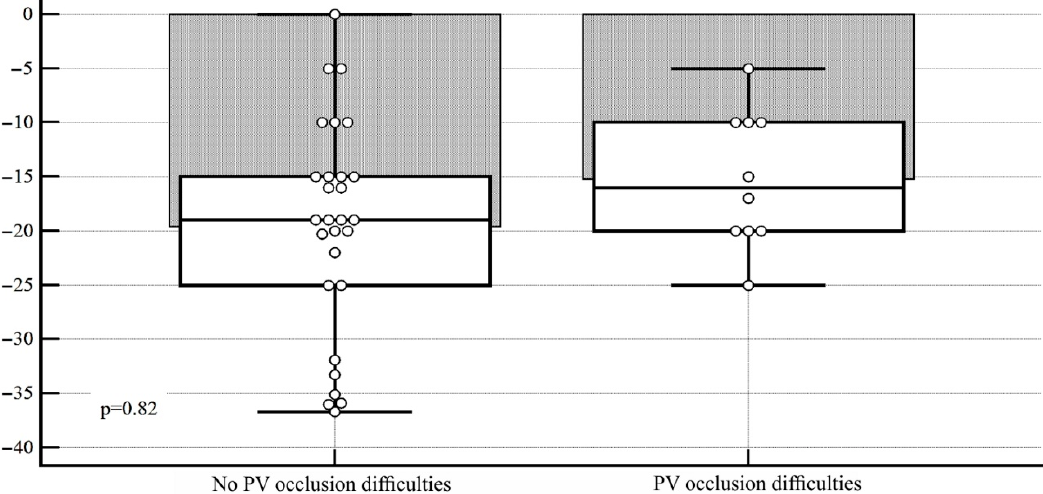
Figure 6. Diagram of angulation ranges of the RIPV in the axial plane, depending on the presence/absence of technical difficulties in positioning the cryoballoon in the ostium. The angulometry data were grouped; for each of the obtained intervals, the likelihood ratio to the development of AF recurrence in the long-term period was calculated. No significant associations were identified (Table 5). Table 5. Influence of PV angulation on long-term